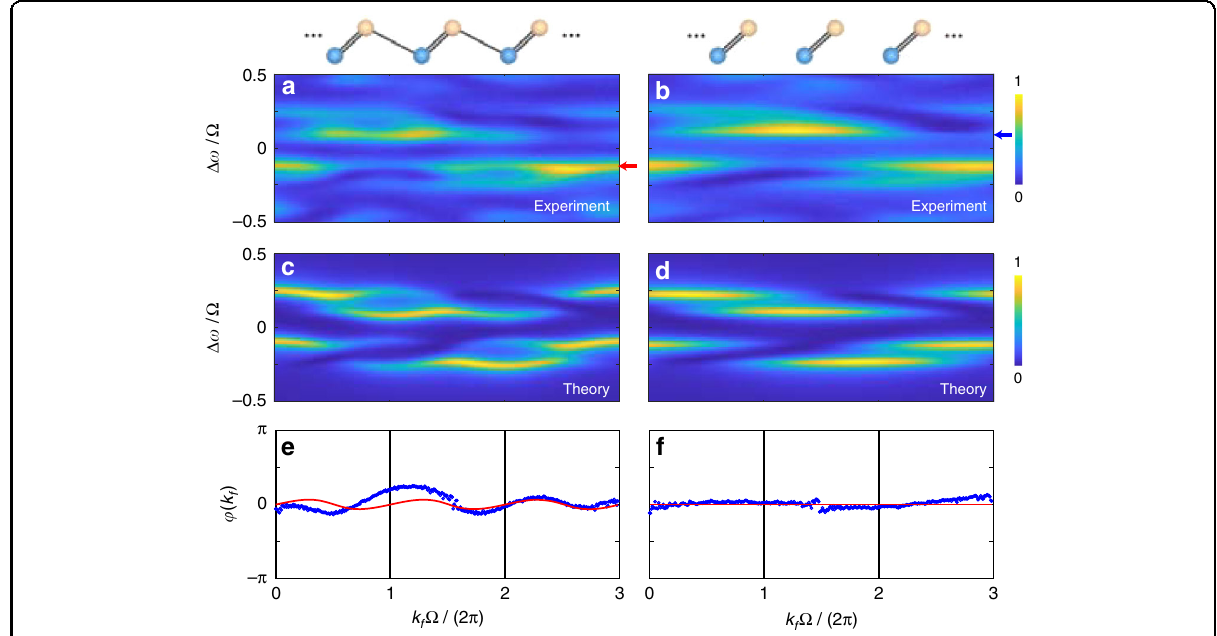
Fig. 5 Measurements of the Zak phase under condition of V1 > V2. Experimental observed band structures with modulation amplitudes a V 1 = 3 V, V 2 = 1 V, and b V 1 = 3 V, V 2 = 0 V. Band structures from simulations under coupling strengths c g 1 = 0.06 Ω , g 2 = 0.02 Ω , and d g 1 = 0.06 Ω , g 2 = 0, with ϕ 1 = ϕ 2 = 0. e , f Measured arguments (blue circles) extracted from the chosen bands in ( a ) (red arrow) and ( b ) (blue arrow), compared with theoretical arguments calculated by G (red lines),